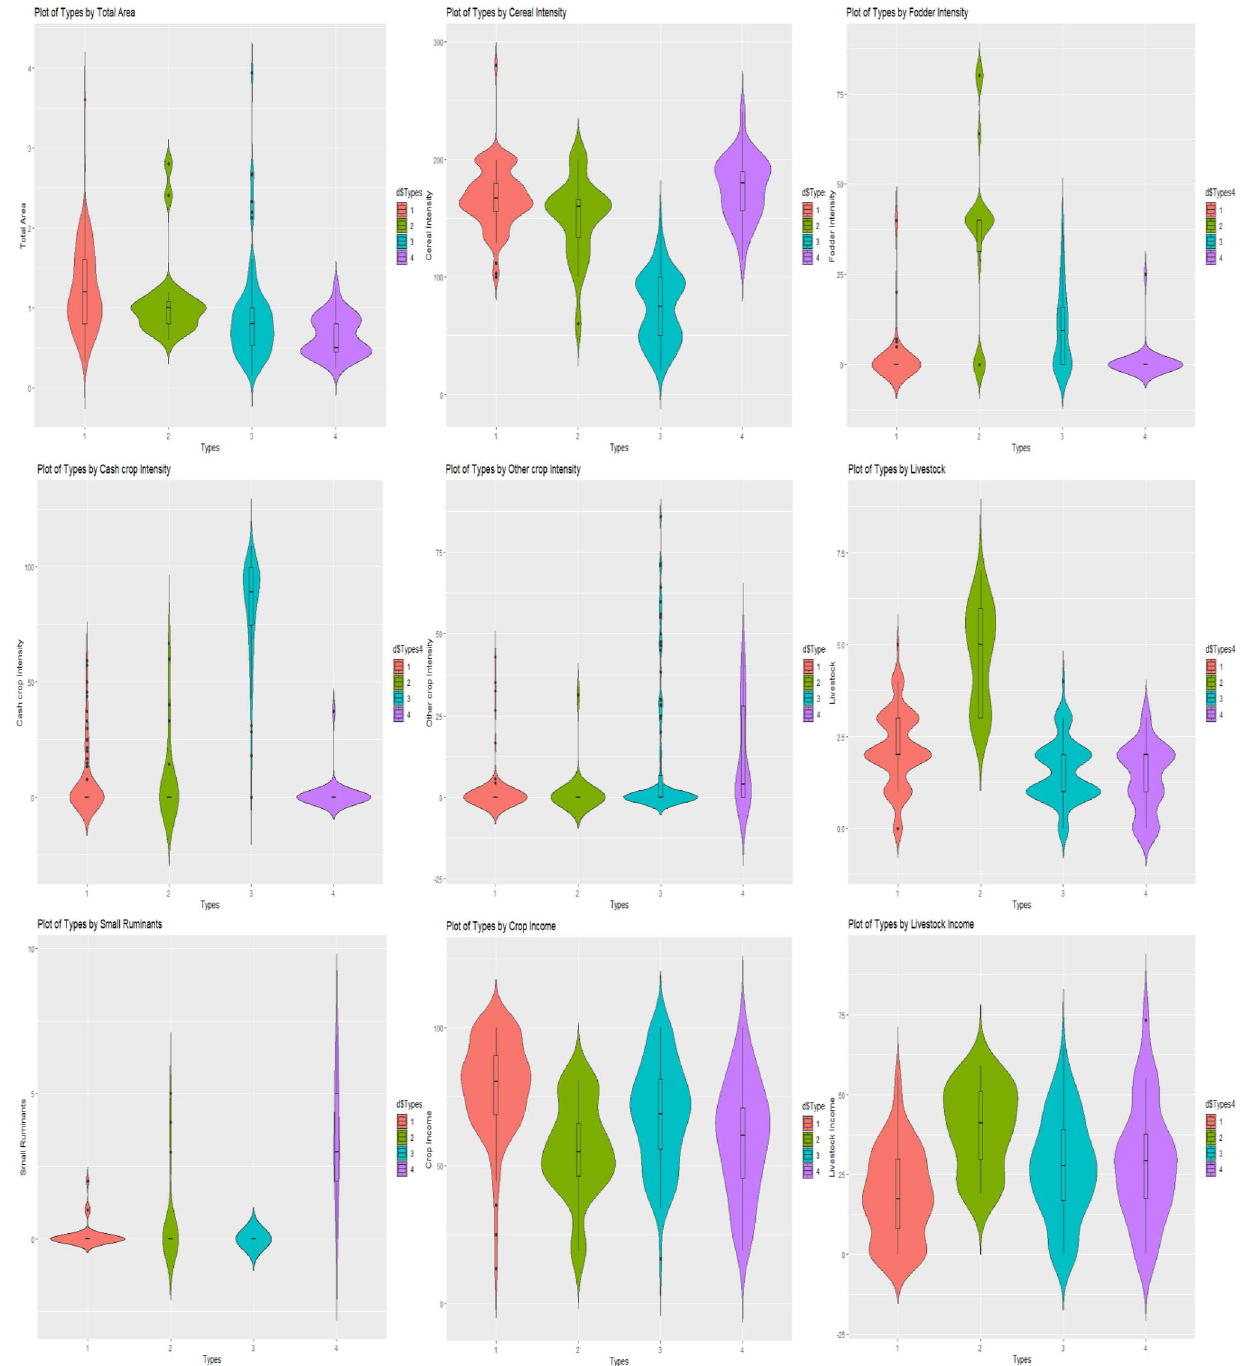
Figure 4. Violin plots showing results of scenario analysis of different variables in farm